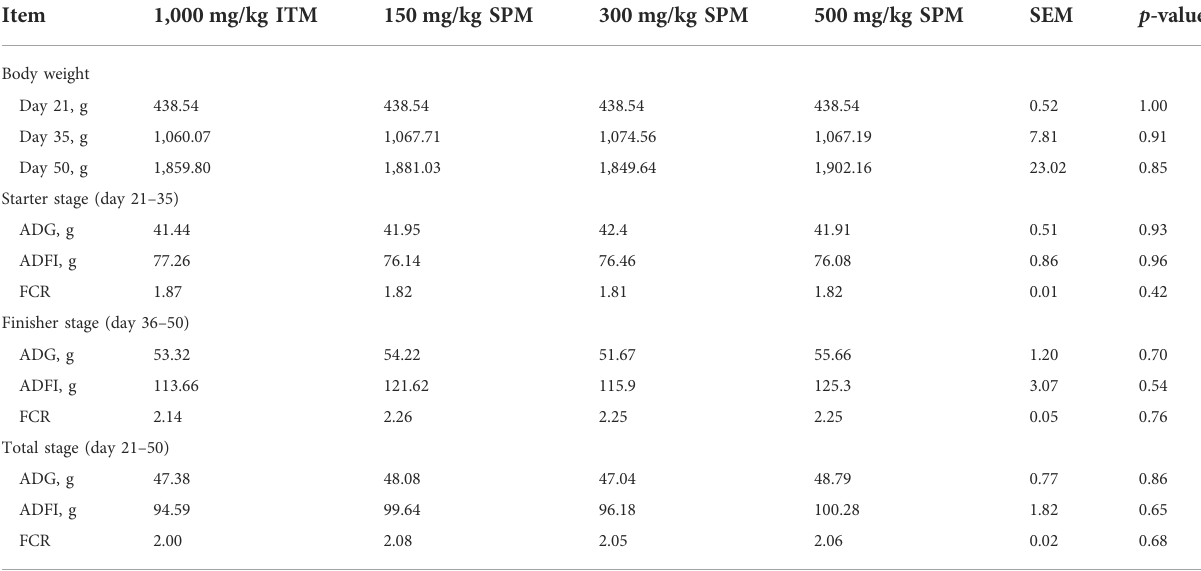
TABLE 3 Effect of supplementation of ITMs and SPMs in basal rations on growth performance of chickens.